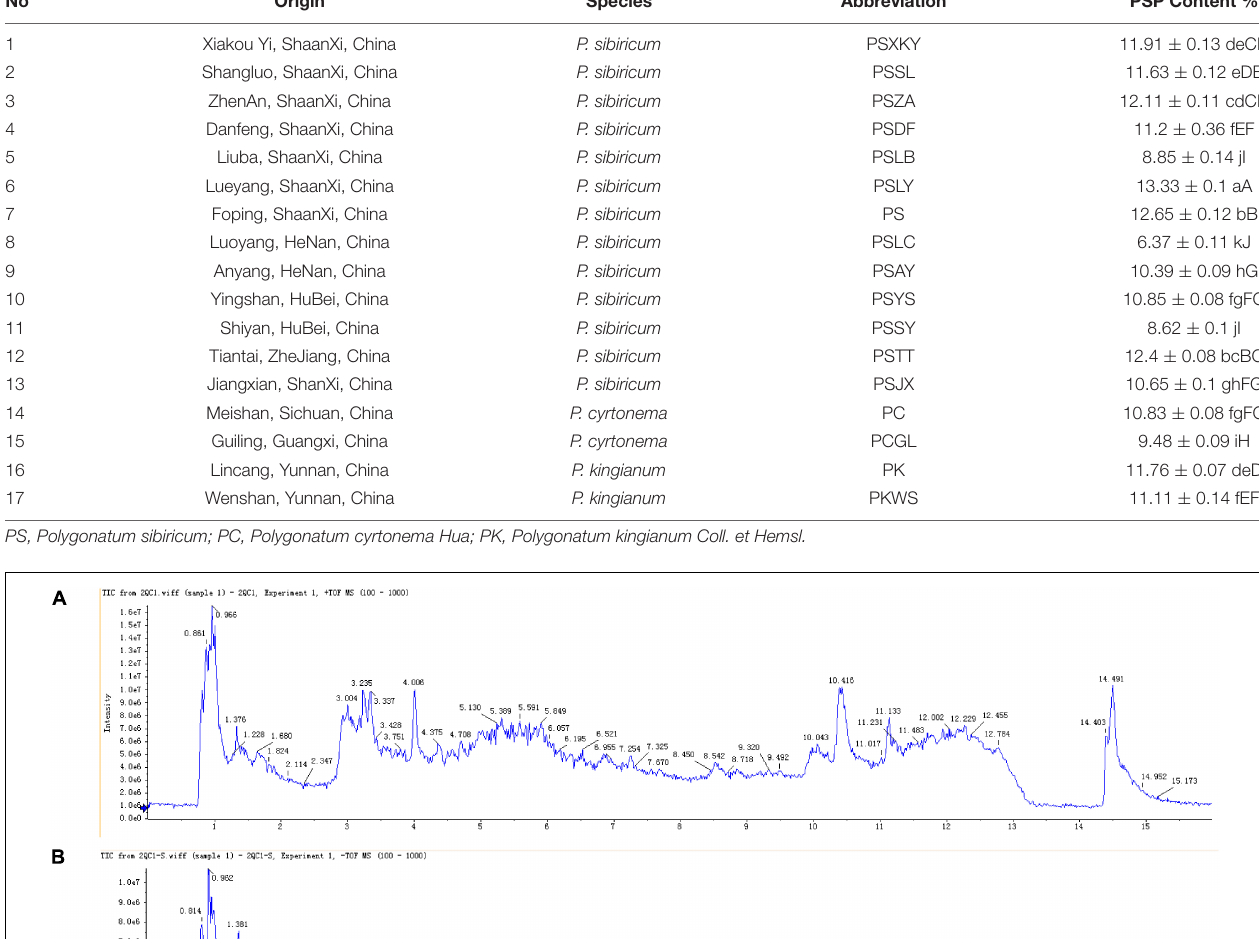
TABLE 1 | Polysaccharide content of P. sibiricum in different germplasm samples. No Origin Species